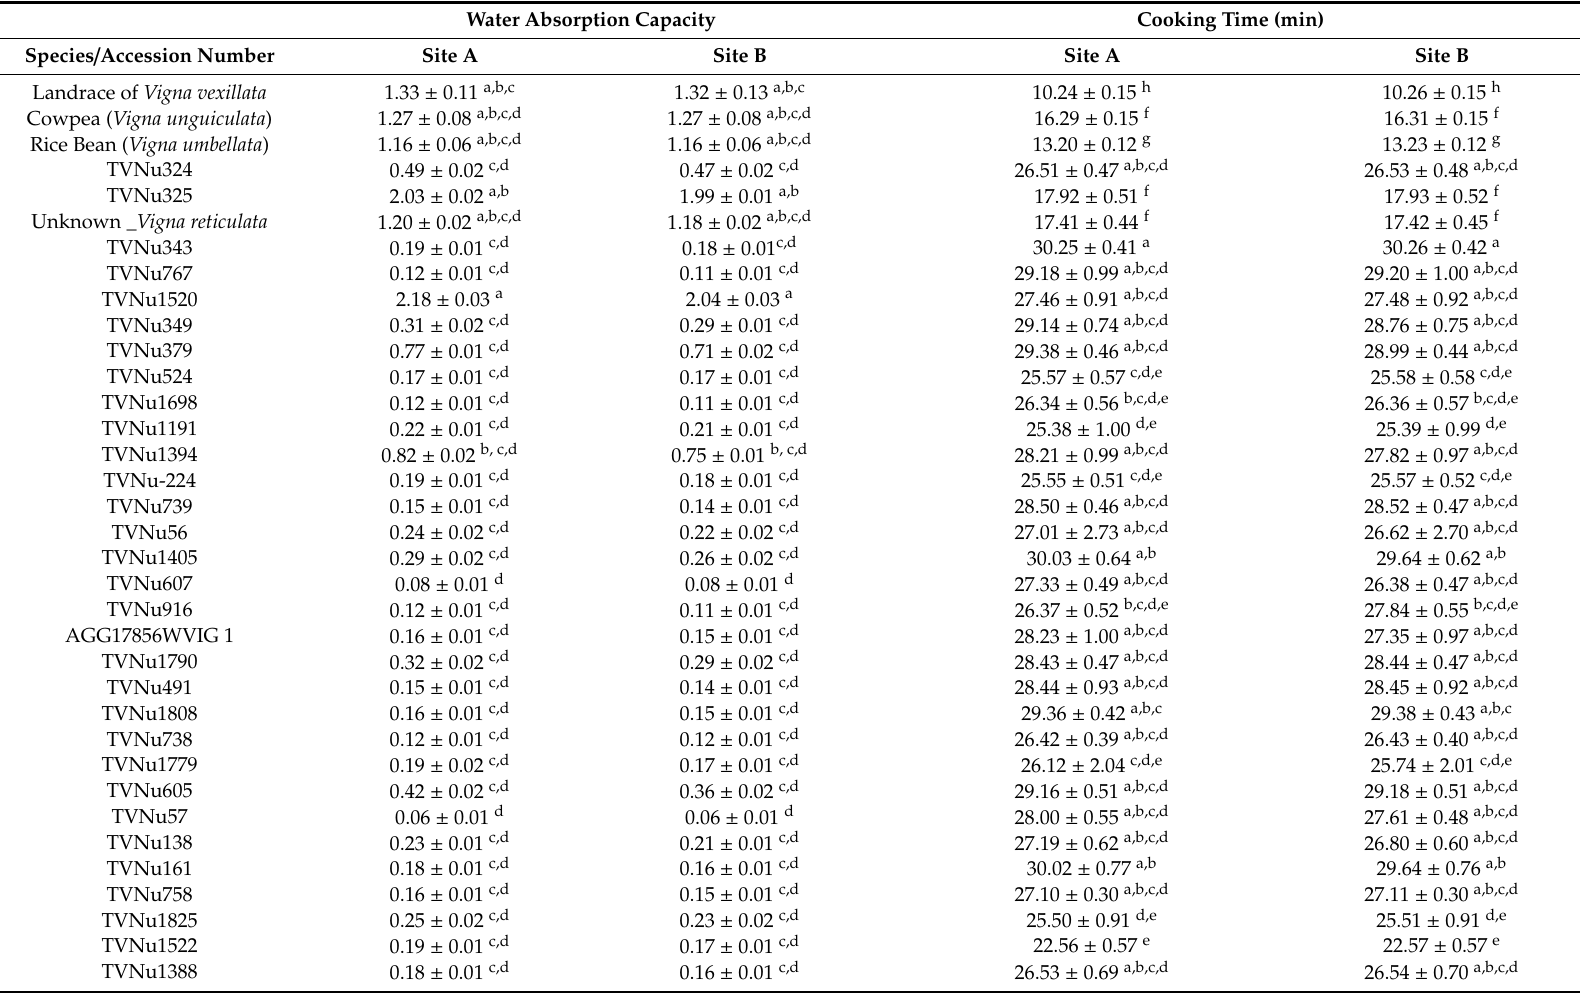
Table 5. Cooking time and water absorption capacity of Vigna reticulata